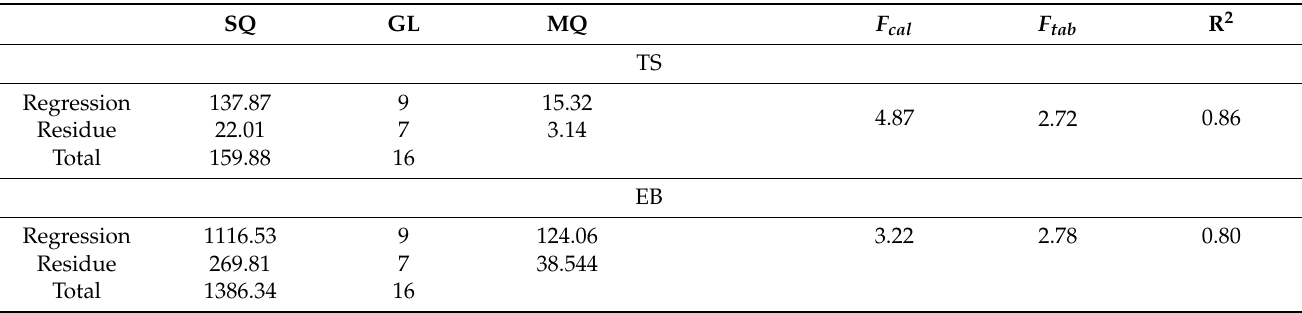
Table 3. Analysis of variation (ANOVA).